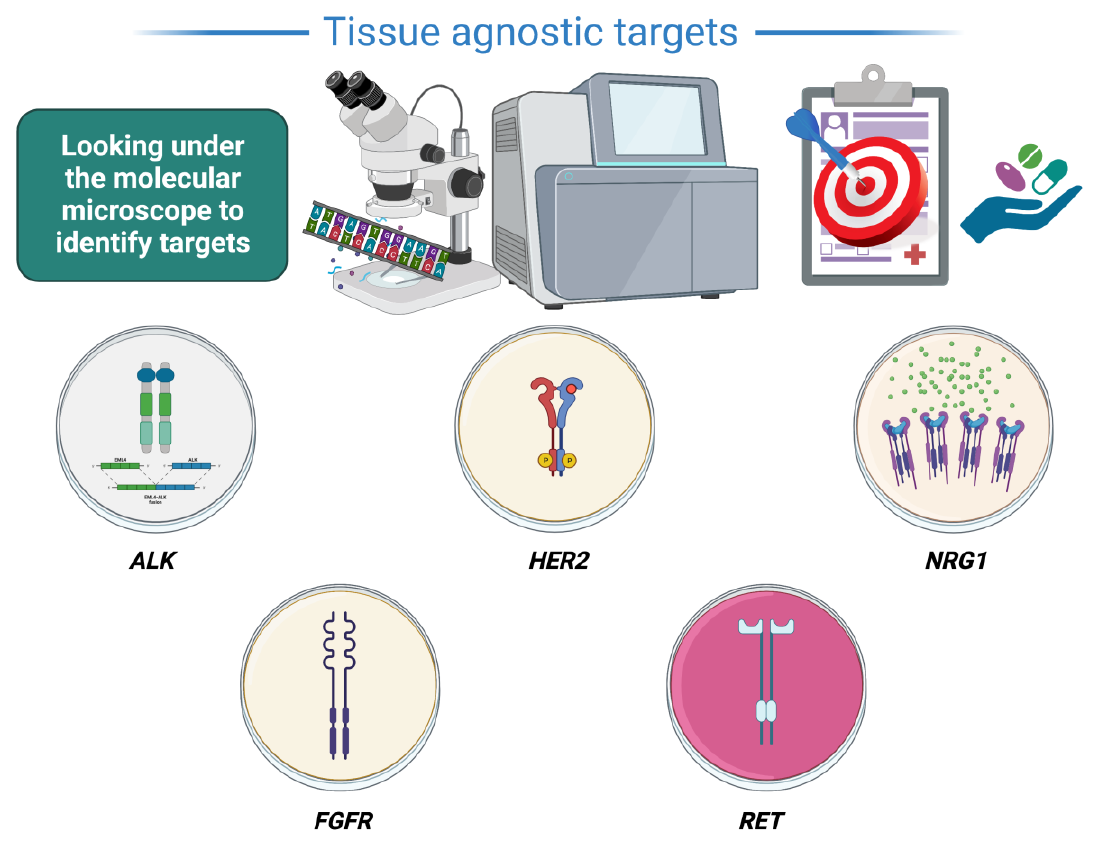
Figure 1. Ongoing clinical trials of tumor-agnostic treatments. Using the ‘molecular microscope’ or next-generation sequencing to identify novel targets that can be targeted with therapeutics.